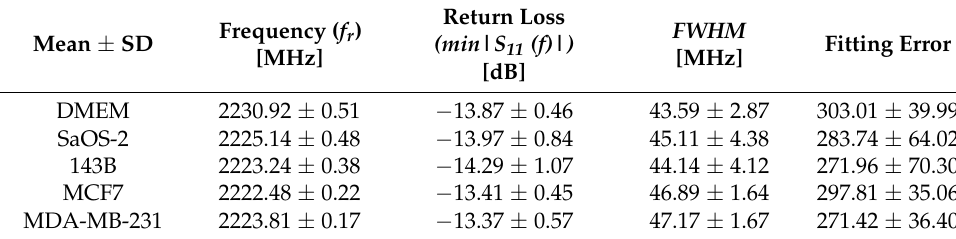
Table 1. Mean ± SD of resonant frequency, min|S 11 (f)|, full width at half maximum, and fitting error. n =